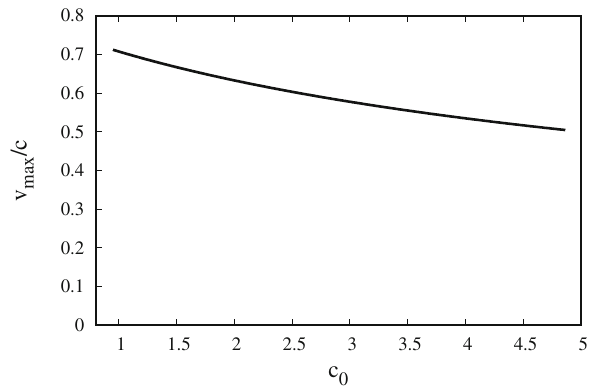
Fig. 9 Proper time Δτ as a function of c